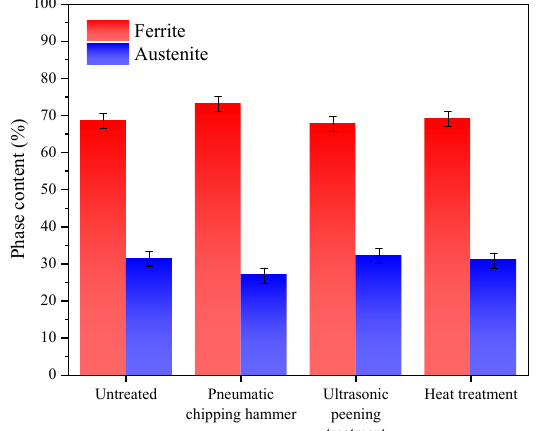
Figure 7. Ferrite and austenite content of DSS 2205 heat-a ff ected zone with di ff erent treatment